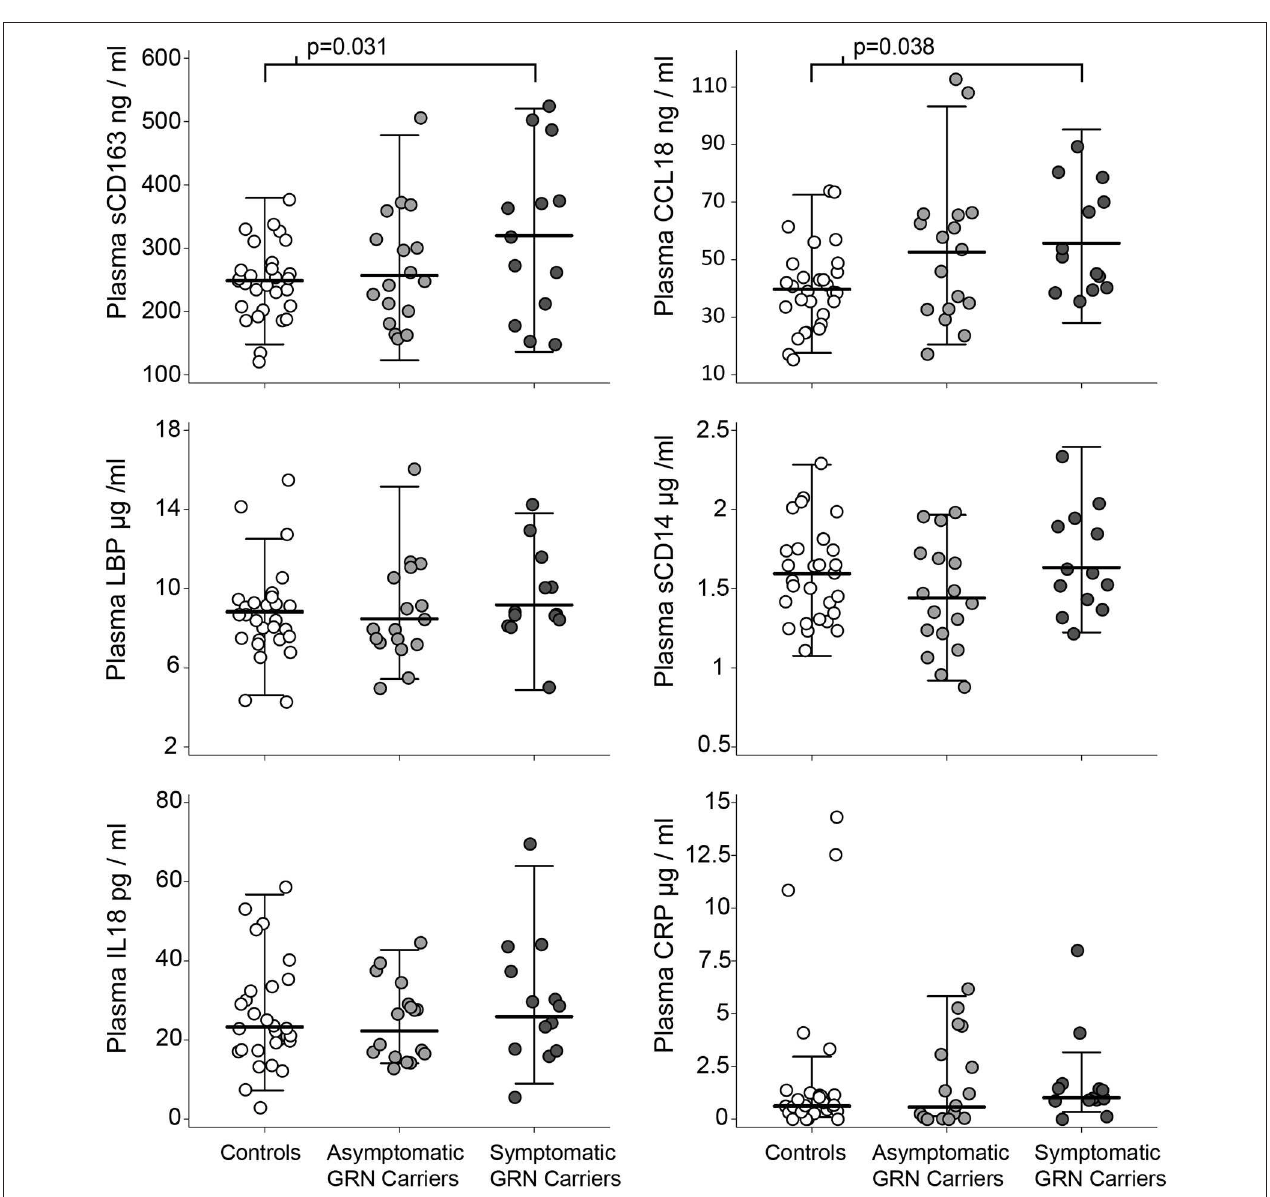
FIGURE 2 | Plasma markers of innate immunity by clinical group. Circles represent individual people in the study. Whiskers represent the highest and lowest adjacent values ( ± 1.5 × interquartile range) with a median line in between. The p -values associated with brackets for the sCD163 and CCL18 plots are post-hoc pairwise Tukey tests (after ANOVA p < 0.05) between controls and symptomatic